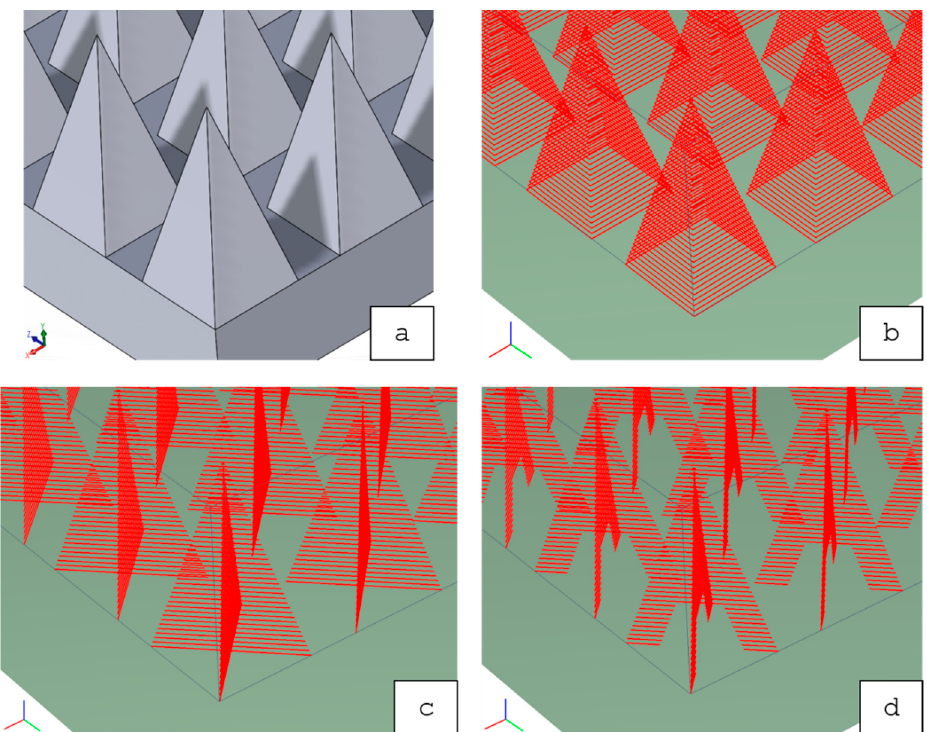
Figure 3. Overview of the four scanning strategies (red lines = scan vectors): ( a ) Contour-CLS (scan vectors [not shown in the sub-figure] are created automatically based on the shown CAD-data); ( b ) Contour-CLI; ( c ) Cross-CLI; ( d ) Crosshair-CLI.